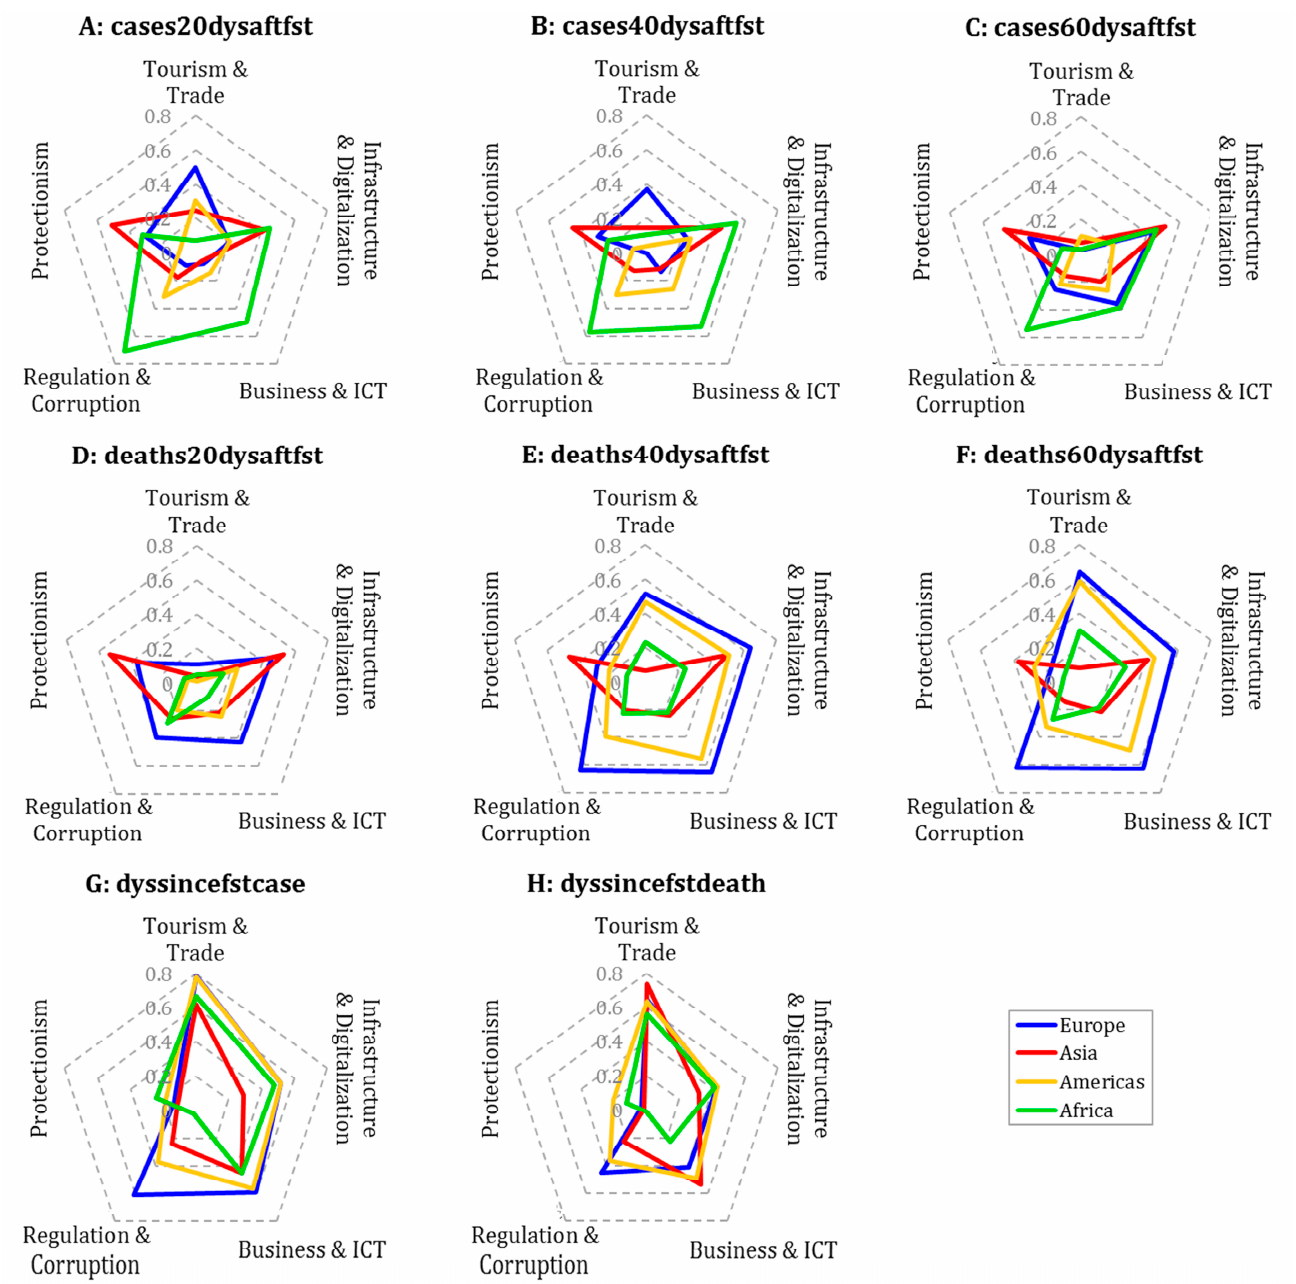
Figure 4. Absolute rank correlation between COVID-19 and latent variables by region. The correlations are presented according to the different COVID-19 variables that measure the total number of cases/deaths per capita after 20 days ( A / D ), 40 days ( B / E ), and 60 days ( C / F ) from the first case/death, as well as the number of days since the first case/death ( G / H